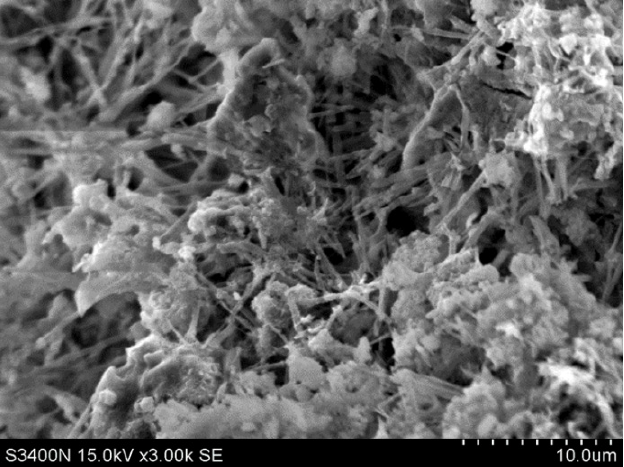
Figure 16. SEM image of microstructures 5 mm below the inner coating of the substrate when W/C = 0.4 (3000×; 4C2, 56 days).